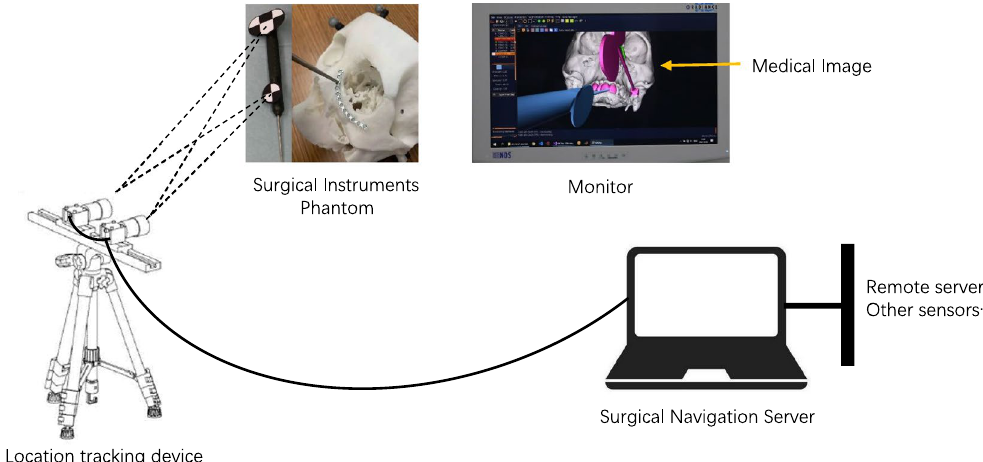
Figure 4. Working principle of optical navigation system. Identification of the probe and the Marker on the braces by the binocular lens for positioning on the model, while the probe and the reconstructed model of the skull are presented in real time on the monitor.